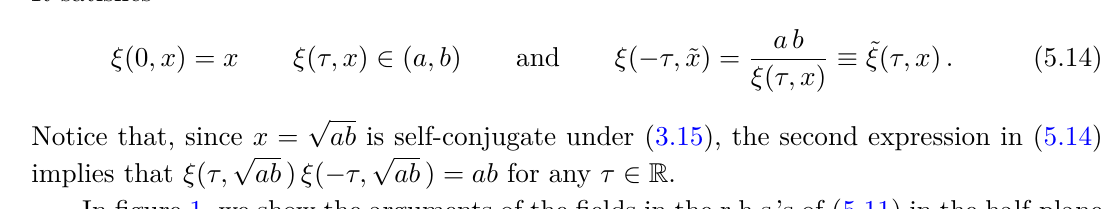
Figure 1 . Modular evolution of the arguments of the fields mixed by the modular flow in the r.h.s’s of (5.11), for a point x (solid lines) and its conjugate ˜ x (dashed lines) at τ = 0 . The blue and the red curves correspond to the first and the second equation in (5.11) respectively. The vertical √ √ √ dotted line identifies the point ab . In the left panel x < ab , while x > ab in the right panel. This function describes the modular evolution (parameterised by τ ∈ R ) of any point x ∈ A